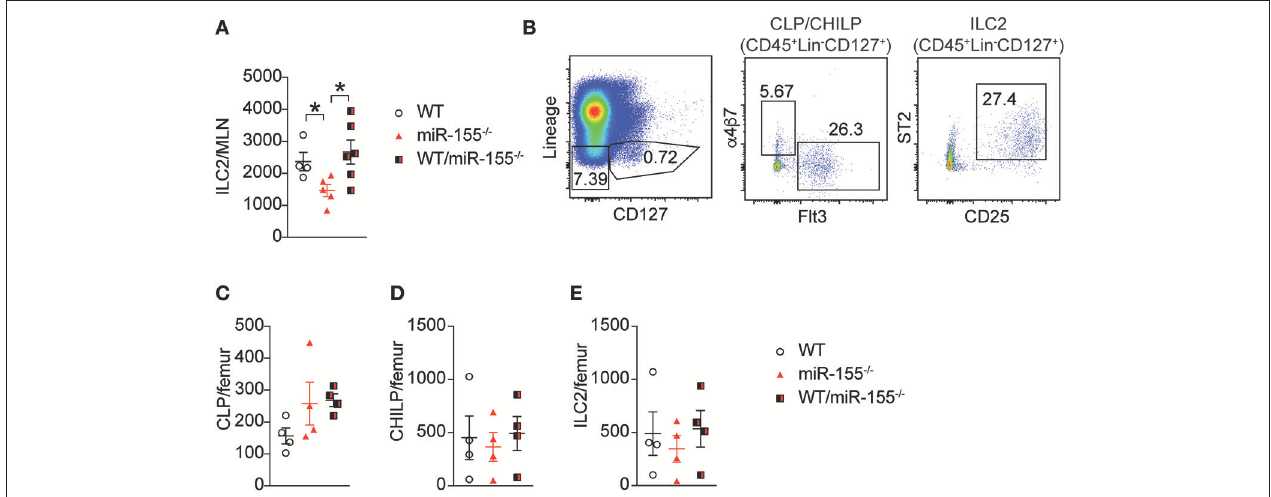
FIGURE 3 | Haematopoetic cell miR-155 is critical for ILC2 expansion. Lethally irradiated B6SJL mice were reconstituted with WT, miR155 − / − or mixed WT/ miR155 − / − BM, and treated with IL-33 for 3 days. (A) Numbers of ILC2 (live CD45 + Lin-CD127 + Sca1 + KLRG1 + ICOS + ) from MLN. (B) Representative staining of BM progenitor cell populations. (C) Enumeration of BM-derived common lymphoid precursors (CLP: Lin − CD127 + Flt3 + ), (D) common helper innate lymphoid precursors (CHILP: Lin − CD127 + Flt3-a4b7 + CD25 − ), and (E) ILC2 precursors (Lin − CD127 + CD25 + ST2 + ). Data are representative of two independent experiments, n = 4–7. * p ≤ 0.05 with Student’s t- test.